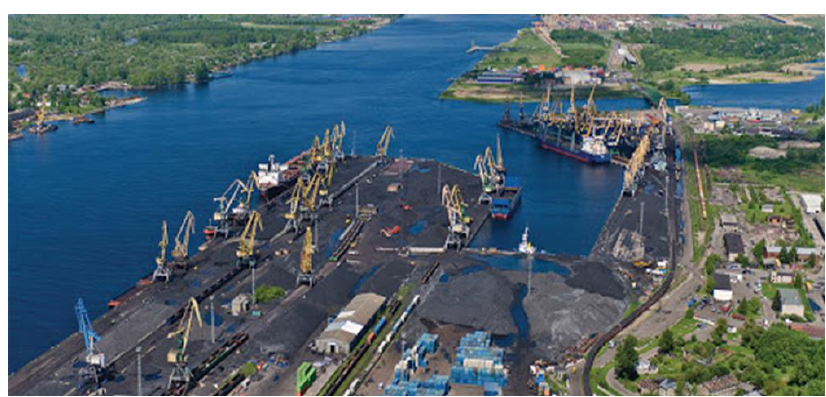
Figure 4. Port of Riga. Source: [68].